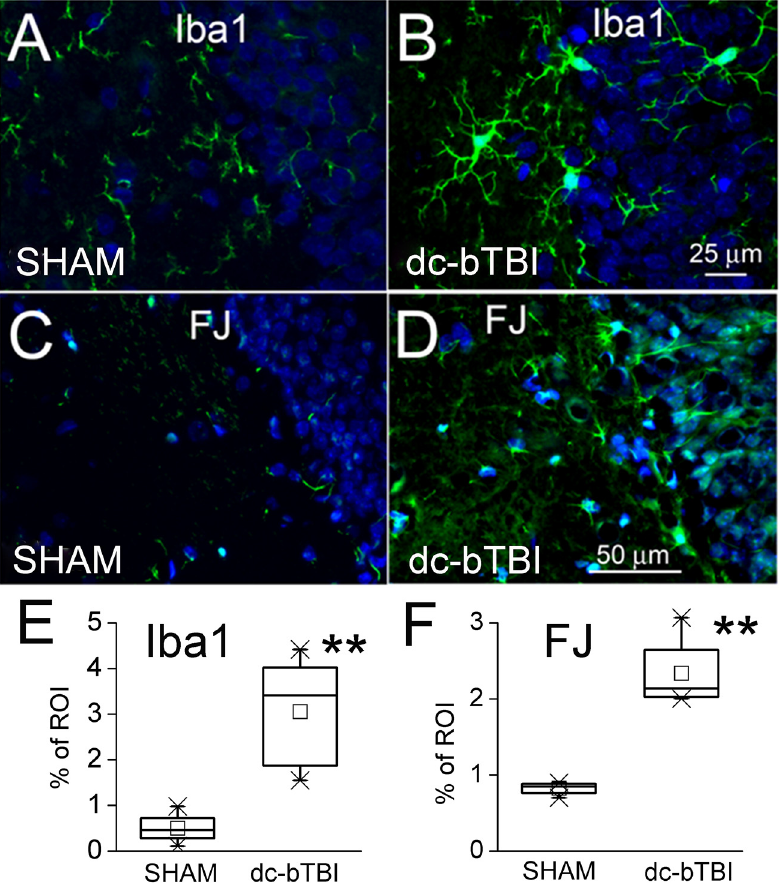
Fig 7. Histochemical findings in the hippocampus in dc-bTBIvs. sham-injured rats at 28 days.A,B: Iba1 immunolabeling (green) for microglia in a sham-injured and a dc-bTBI rat,respectively. C, D: Fluoro-Jade C (green) for neurodegeneration in a sham-injured and a dc-bTBI rat, respectively. E,F: Quantification of Iba1 immunolabeling and Fluoro-Jade C staining in sham-injured and dc-bTBI rats; in A – D, DAPI (blue) nuclear labeling is also shown; n = 5 per group; ** , p < 0.01for comparison between sham and dc-bTBI